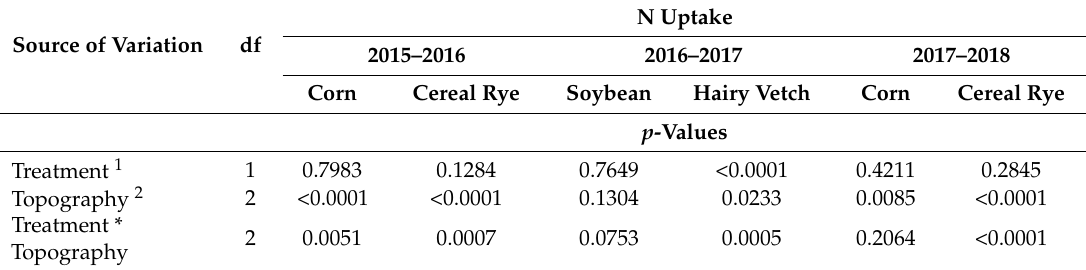
Table 2. Probability values ( p -values) and numerator degrees of freedom (df) associated with the sources of variation in the statistical analysis of N uptake by the cover and cash crops.